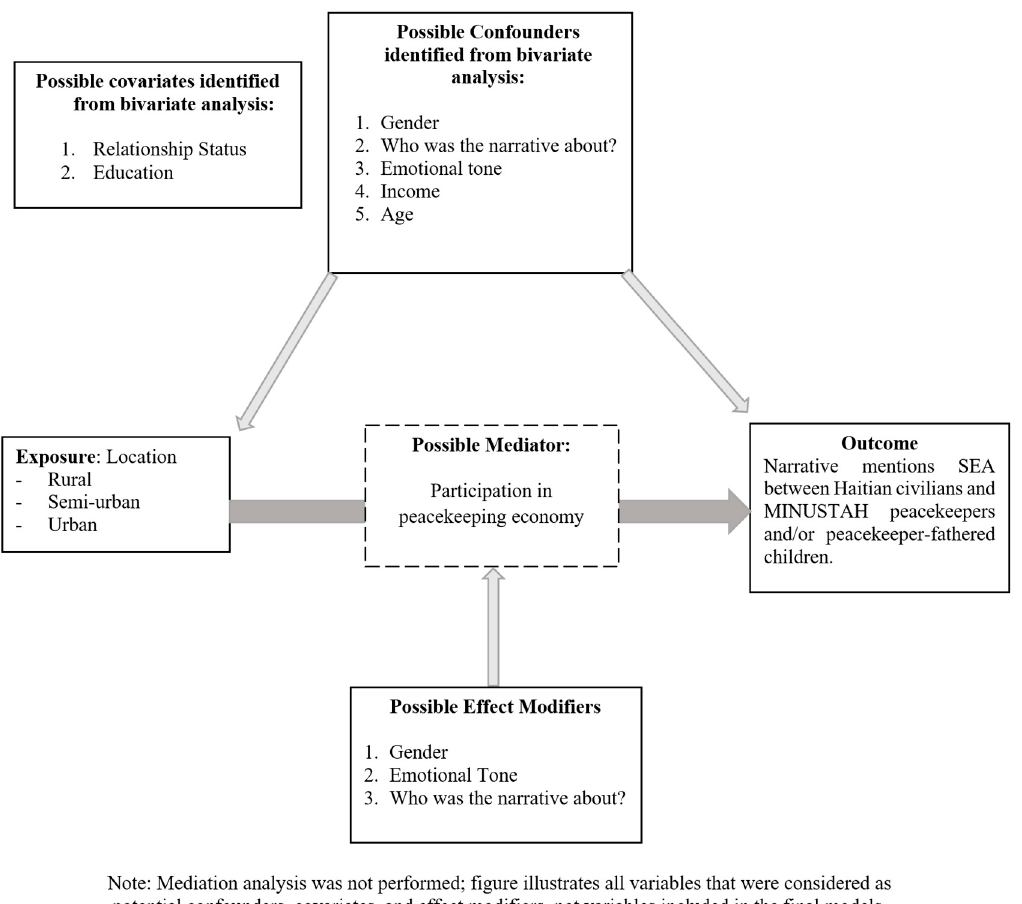
Figure 1. Conceptual Model for Objective 1.